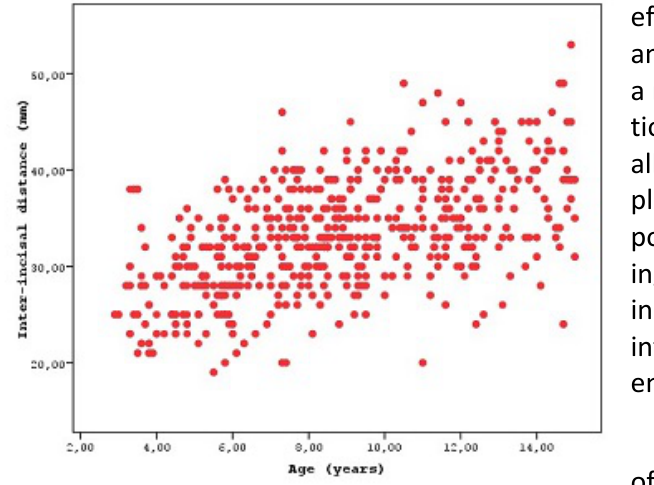
Figure 1. Scatterplot of the correlation between inter-­‐ incisal distance and age of all children (girls and boys).